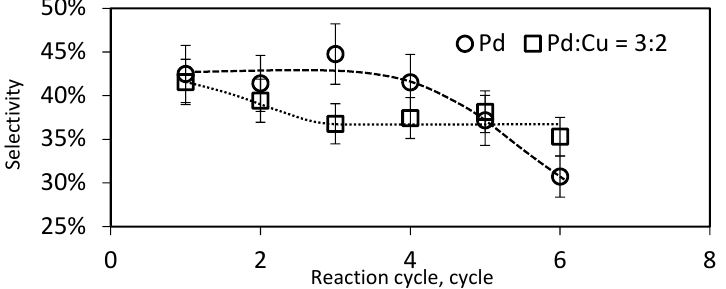
Figure 7. The 1,3 ‐ butadiene selectivity of Pd/Al 2 O 3 and Pd:Cu 3:2 on Al 2 O 3 catalysts as a function of the reaction cycles.